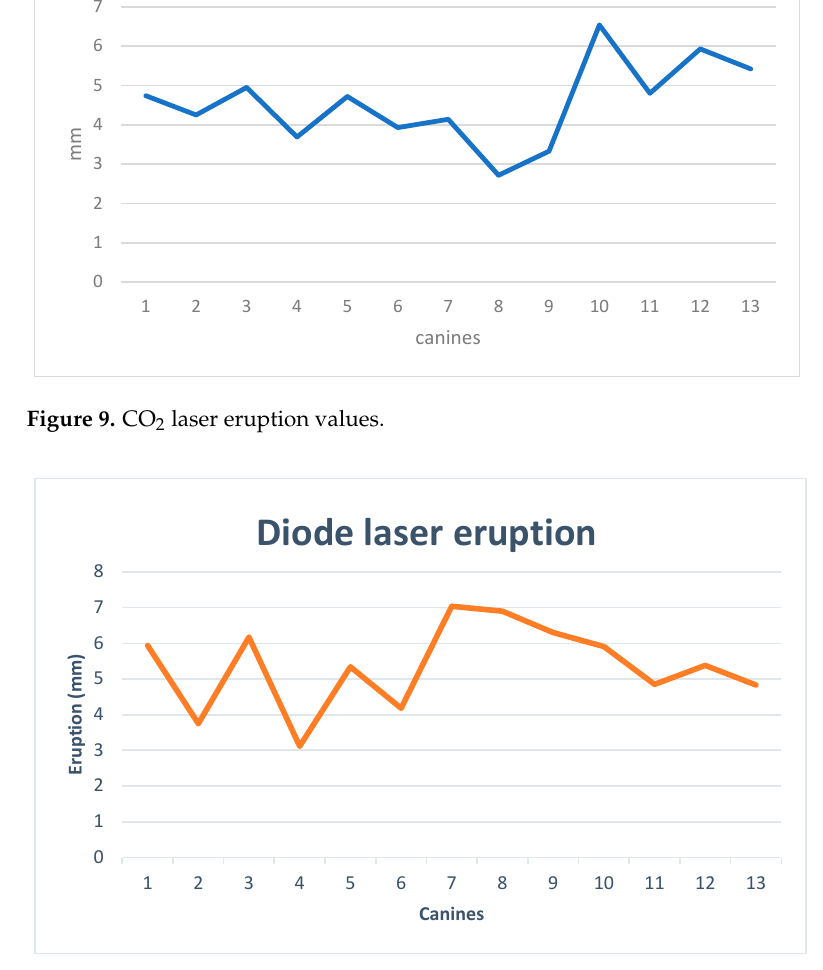
Figure 10. Diode laser eruption values.